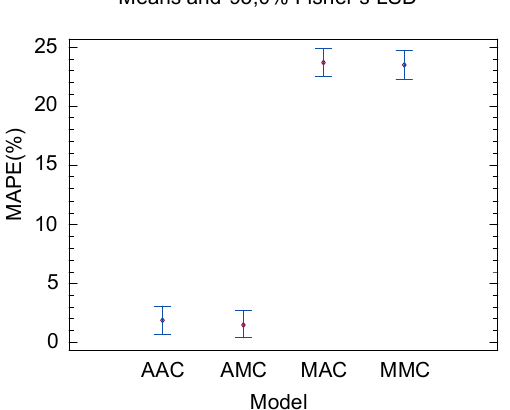
Figure 2. Means and Fisher’s LSD (least significant differences) diagram of the MAPE obtained against the nHWT models considered.